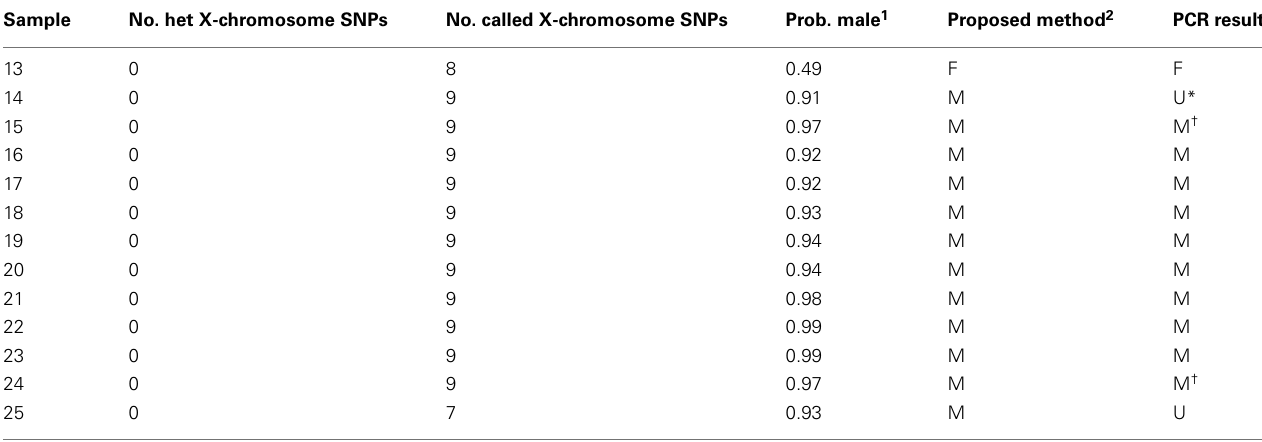
1 Fitted probability of being labeled male under the proposed method. 2 Gender call based on an arbitrary threshold of 0.5 for fitted probability of being labeled male. † Confirmed as sample errors involving switched genders, likely due to sample